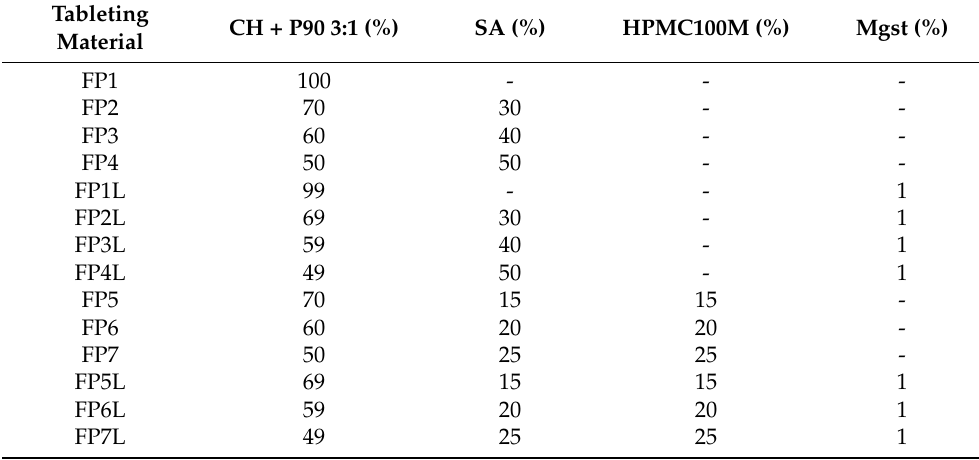
Table 2. Composition of tableting materials with chitosan and P90 at a ratio of